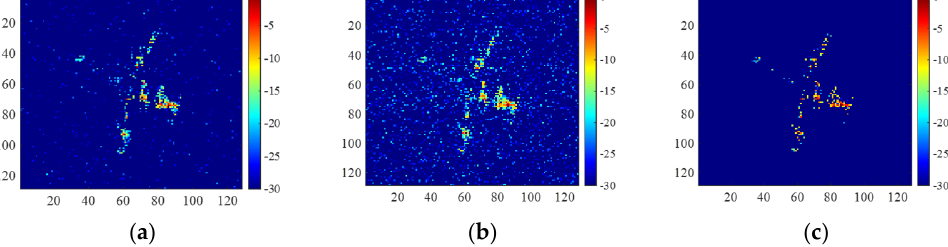
Figure 12. Yak ‐ 42 images of the incomplete range data obtained by ( a ) 2D ‐ FISTA, ( b ) untrained 2D ‐ Figure 12. Yak-42 images of the incomplete range data obtained by ( a ) 2D-FISTA, ( b ) untrained ADN, and ( c ) trained 2D ‐ ADN. 2D-ADN, and ( c ) trained 2D-ADN. Table 5. Quantitative performance evaluation for the incomplete range measured data. Table 4. Quantitative performance evaluation for the incomplete range measured data.